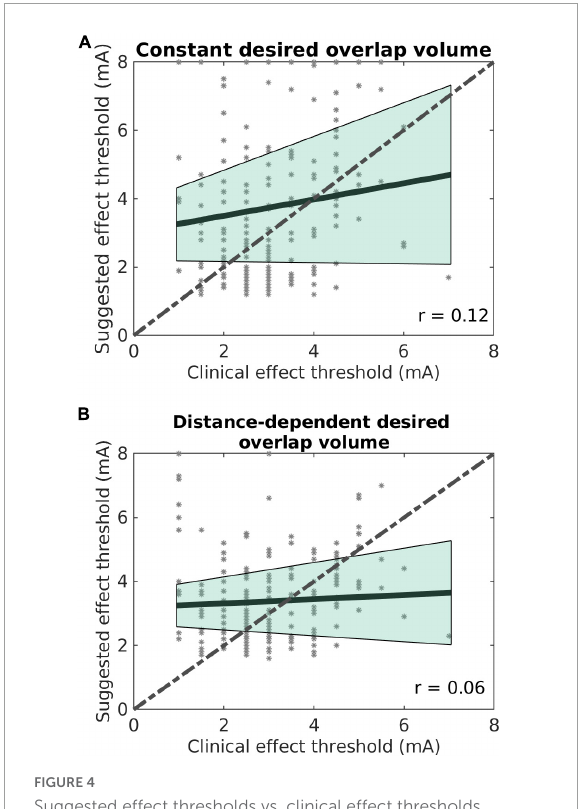
FIGURE4 Suggested effect thresholds vs. clinical effect thresholds. (A) Using the constant desired overlap volume. (B) Using the distance-dependent desired overlap volume. The shaded areas represent the 95% confidence intervals.